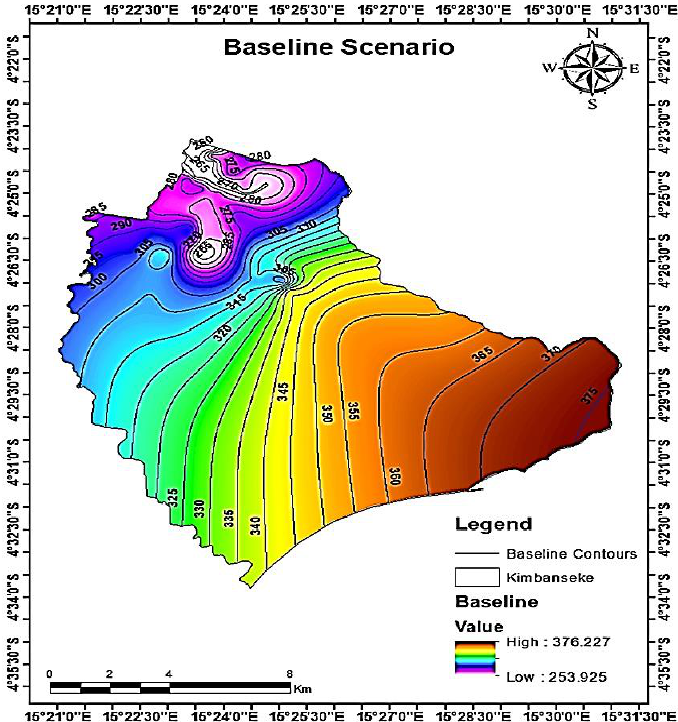
Figure 18. Baseline scenario. (Source: Authors).